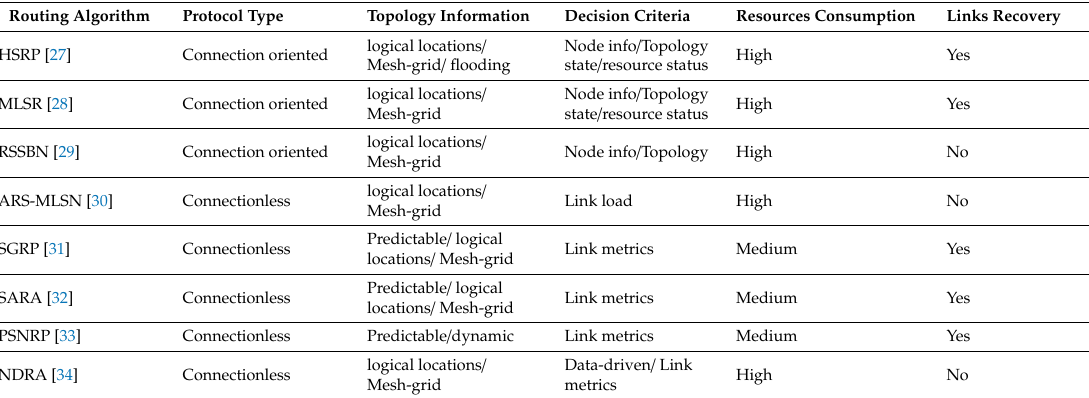
Table 3. Multi-layer routing